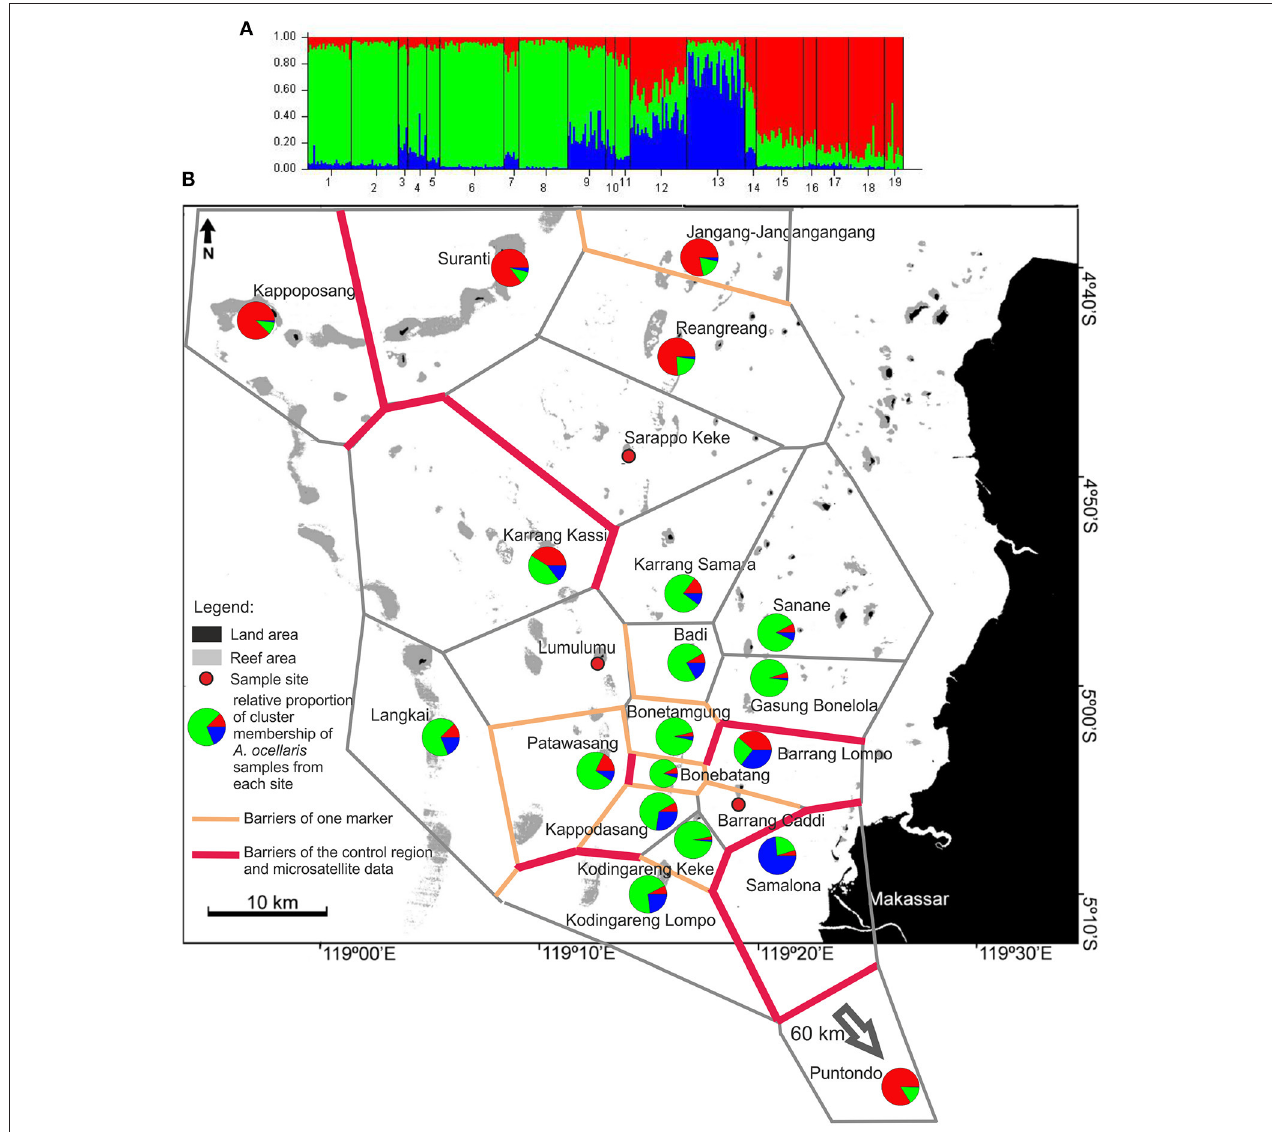
FIGURE 4 | (A) of the figure shows the frequency diagram generated by STRUCTURE (ver. 2.2., Pritchard et al., 2000) as part of the analysis output showing the proportional cluster membership of sampled clown anemonefish, A. ocellaris , at the sites. (B) Shows the summarized results of the BARRIER analysis (Manni et al., 2004) based on two datasets (control region and microsatellites, A. ocellaris ) and STRUCTURE analysis. For BARRIER, the 10 strongest/most important barriers to gene flow are shown. Red lines indicate barriers detected in both data sets, while orange lines indicate barriers detected in only one dataset. The polygon structures (gray lines/grit) are Voronoï-Tesselations (Voronoï, 1908) as implemented in the software BARRIER (Manni et al., 2004). The pie charts depict the relative proportion of membership of individuals from each site in the three genotype clusters as generated by STRUCTURE (ver. 2.2., Pritchard et al., 2000). The analysis was run for all k from 1 to 10, with the highest probability of correctly dividing the data into k = 3 groups (Supplementary Material 3, Table 1 ). The analysis used the LOCPRIOR model on 316 individuals, from 19 sites, using data from 6 microsatellite loci. The burn-in period was set to 80,000 and 100,000 replicates were